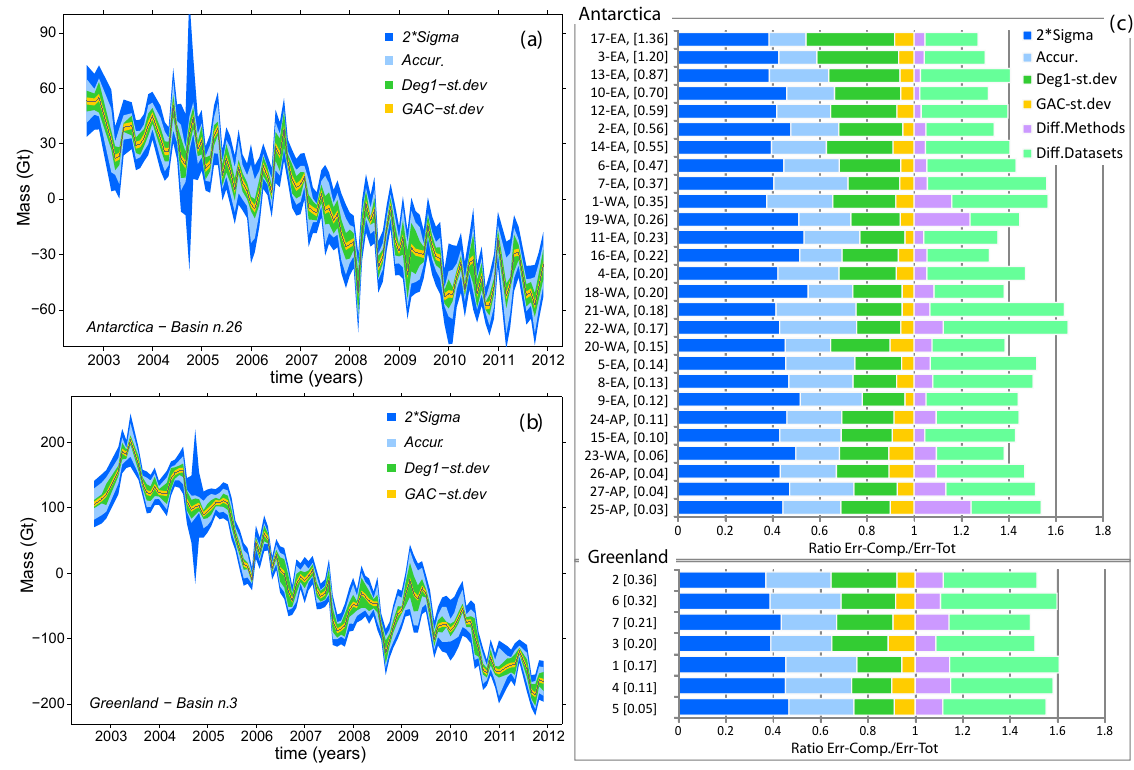
Fig. 7. Monthly average solution for basin 26, Antarctic Peninsula (a) , and basin 3 for Greenland (b) . Each color in the band around the average represents a contribution to the error estimate: the blue is the 2sigma propagated from the data-calibrated errors, the light blue is the accuracy error computed as described in Sect. 3.5, the green is the standard deviation for the degree-1 component, and the yellow is the standard deviation computed for the GAC correction as the grey band shown in Fig. 1. In (c) , the same colors are used to refer to the same component, but for each basin here the average (over the whole time series) of the component is plotted with respect to the average of total error. The light-purple and light-green bars (one on top of the other) represent the same quantity of Fig. 4 in light colors bars (light purple and light green, one beside the